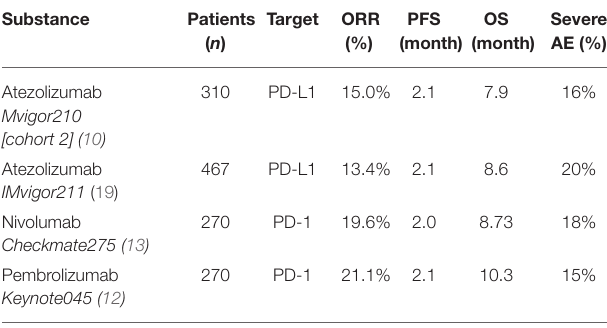
TABLE 4 | Overall response rates (ORR), progression free survival (PFS), overall survival (OS) and severe adverse events (AE, Adverse events according to the common terminology criteria for adverse events, grade ≥ 3) for patients treated with checkpoint inhibition monotherapy for metastatic urothelial carcinoma in the second-line